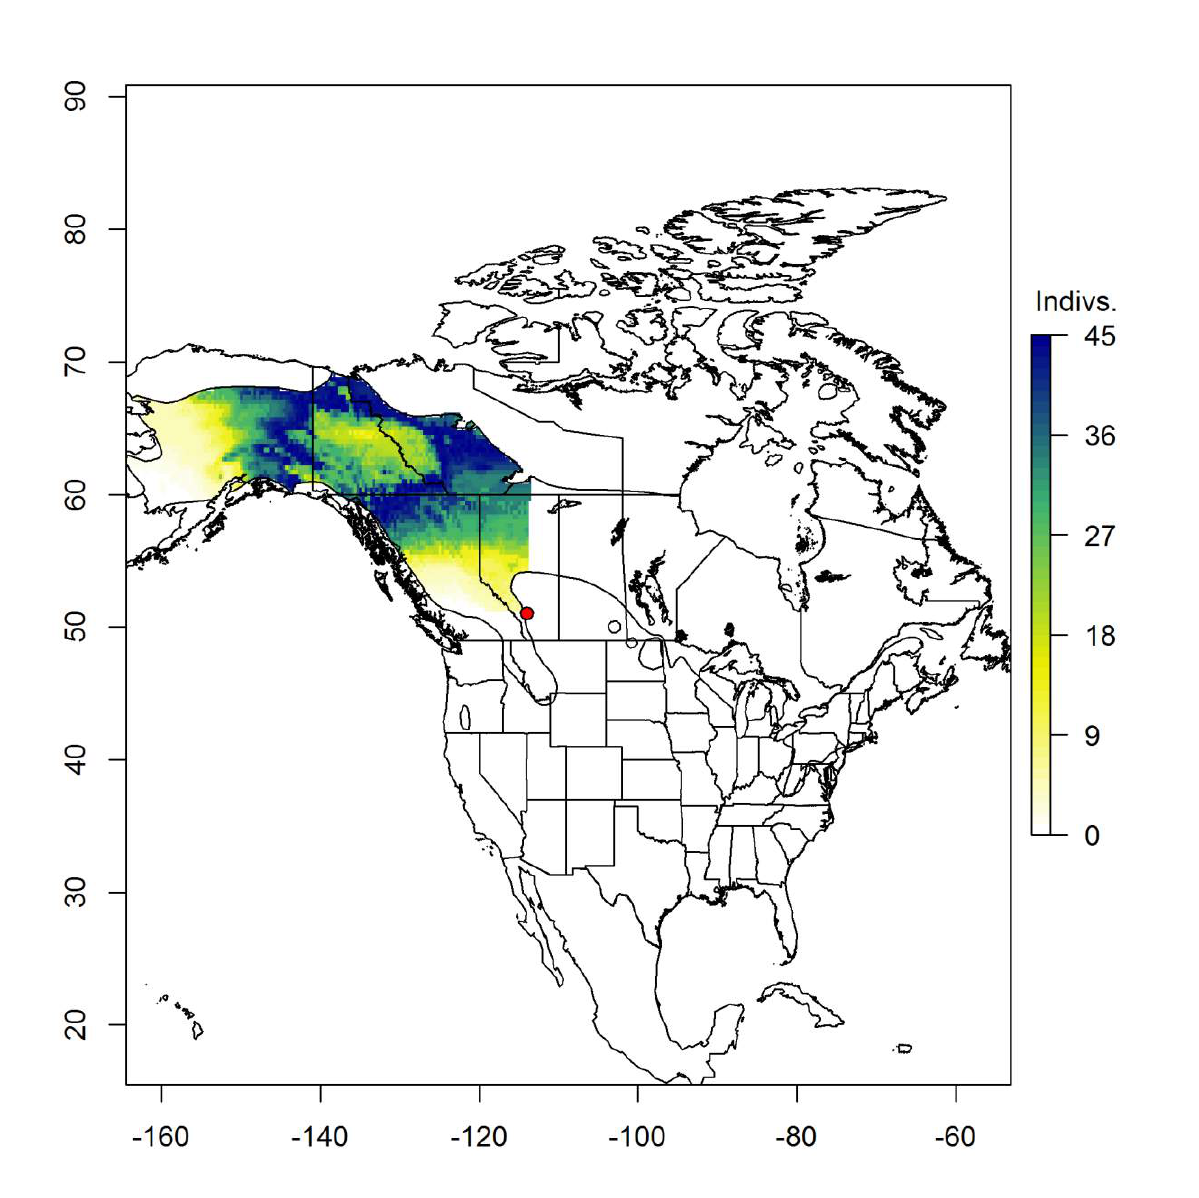
Figure A2.10: Probable origins of Northern Waterthrushes ( Parkesia noveboracensis ) during fall migration at the IBS CMMN station in Southern Alberta